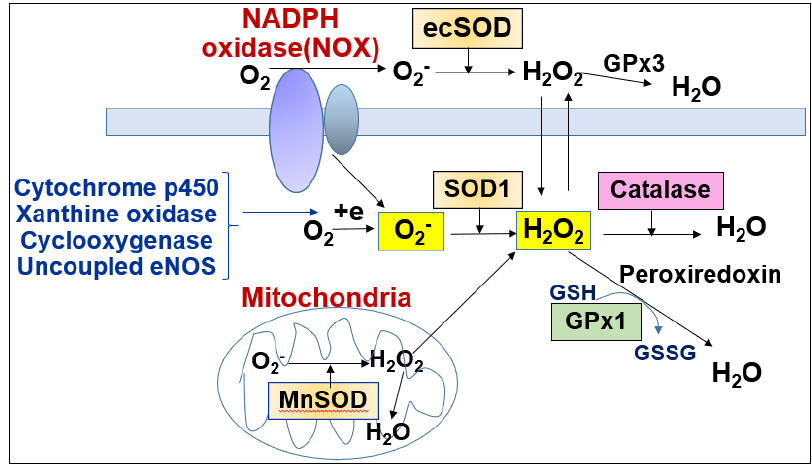
Figure 2. Generation and metabolism of ROS in ECs.